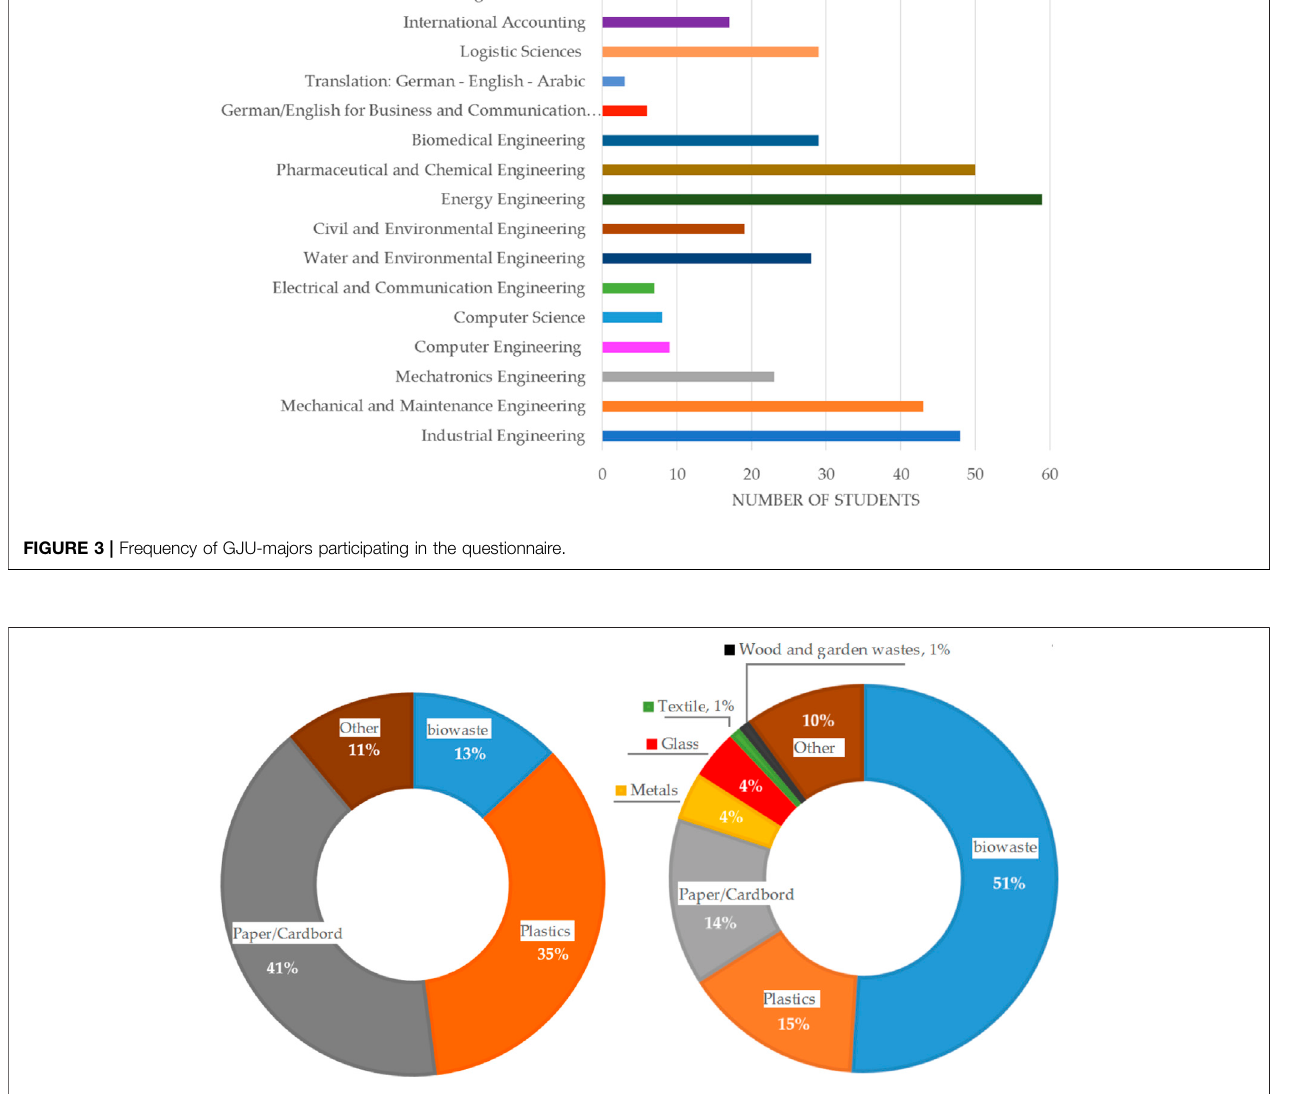
Frontiers in Built Environment |